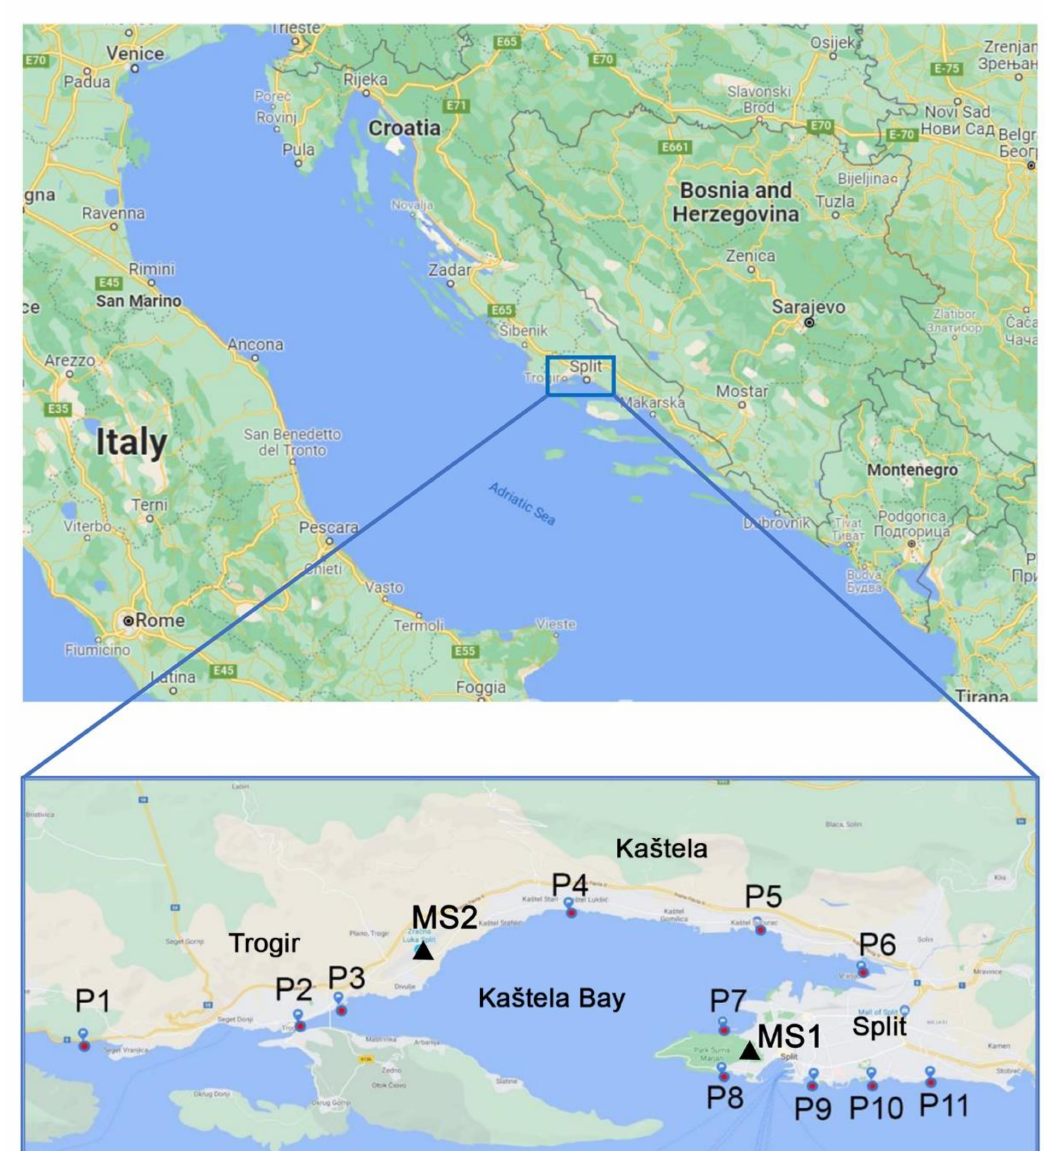
Figure 1. Study area with meteorological stations (MS1 and MS2) and sampling